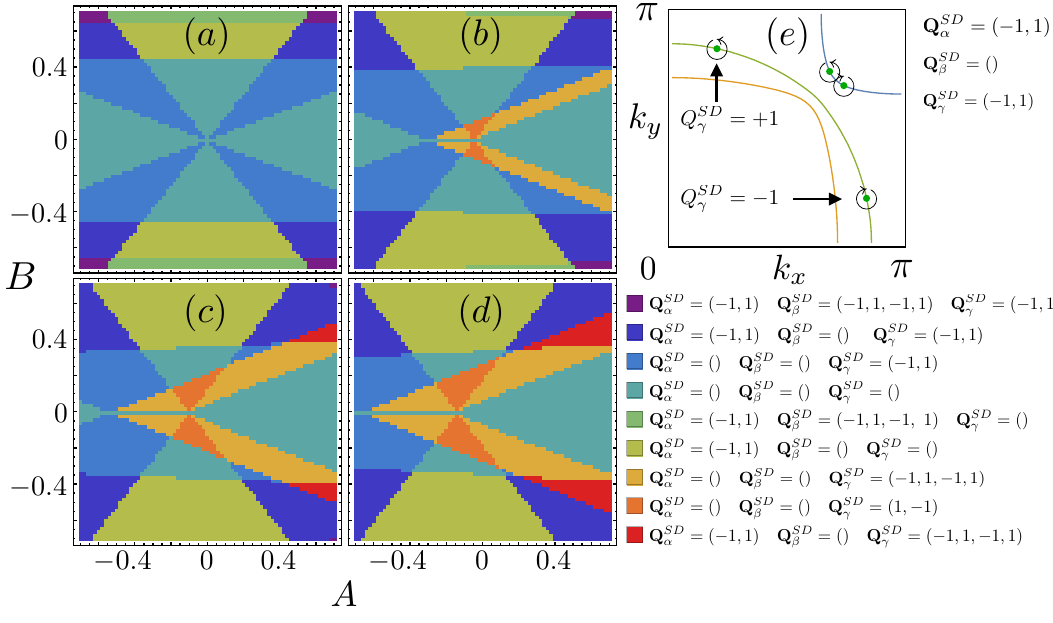
,0.12 t ,0.17 t , re- L L L ( n = α , β , γ ) labeling the charges n